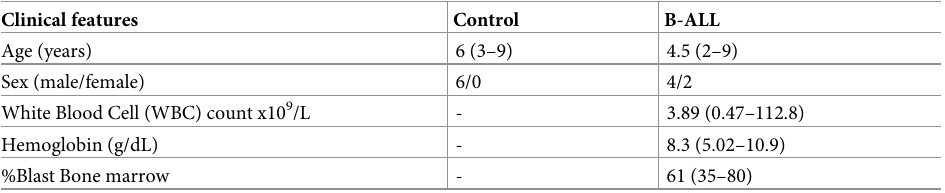
Table 1. Clinical characteristics of B-ALL